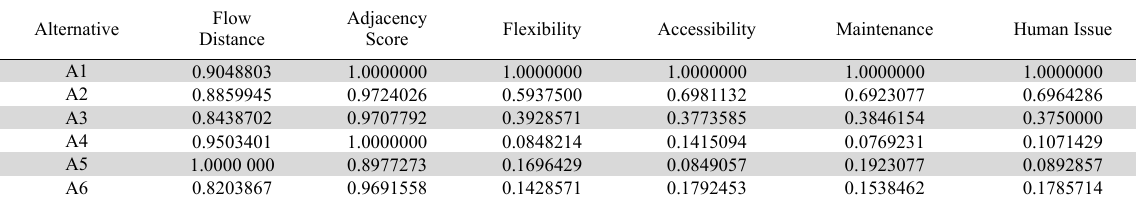
Normalised decision matrix for WASPAS method